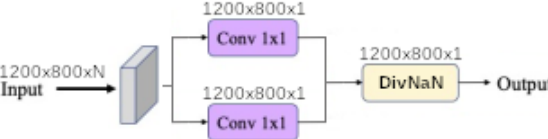
Figure 4. Linear ratio model.